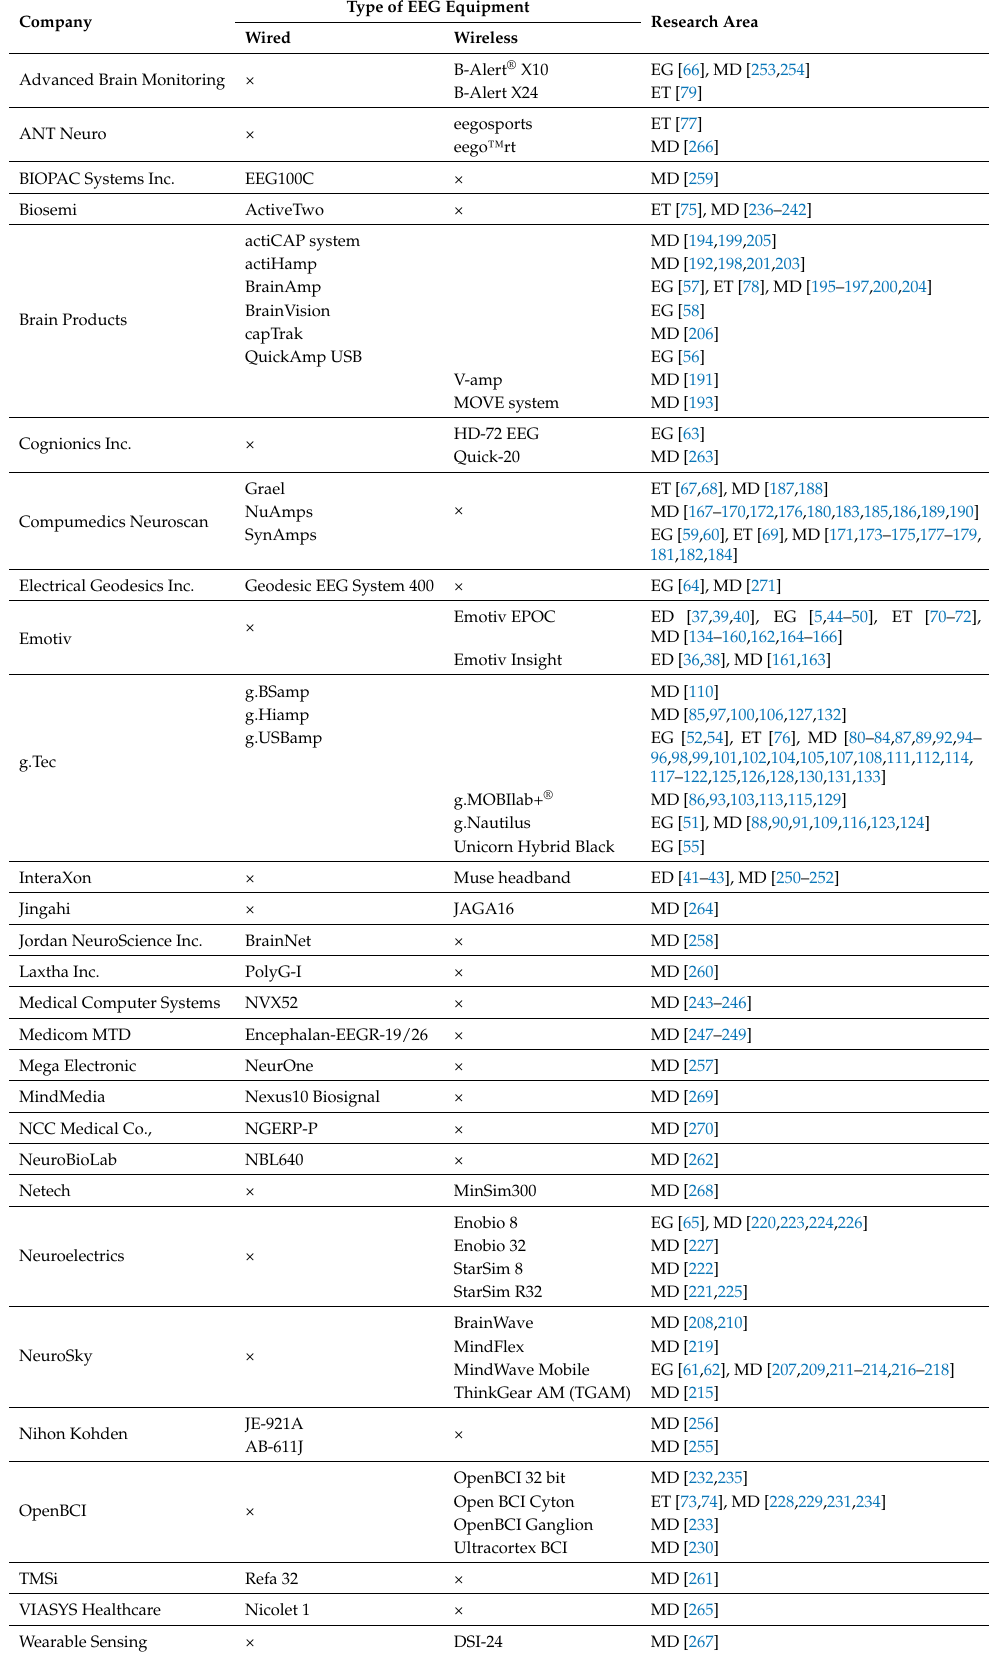
Table 2. Types of EEG equipment for each